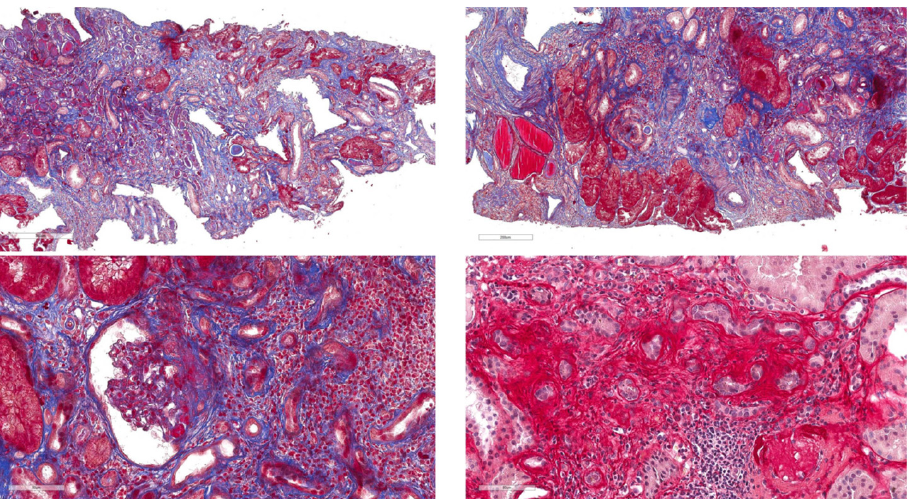
Figure 4. Case 1 kidney biopsy. Light microscopy and immunohistochemistry revealed a classic FSGS with IgM and C3 mesangial deposits, a picture shared with his mother; immunohistochemistry revealed increased deposition of extracellular matrix.